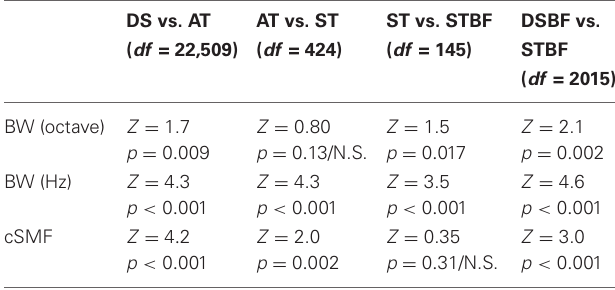
Table 1 | Spectral receptive field similarity between neighboring neurons and their dependence on proximity and frequency